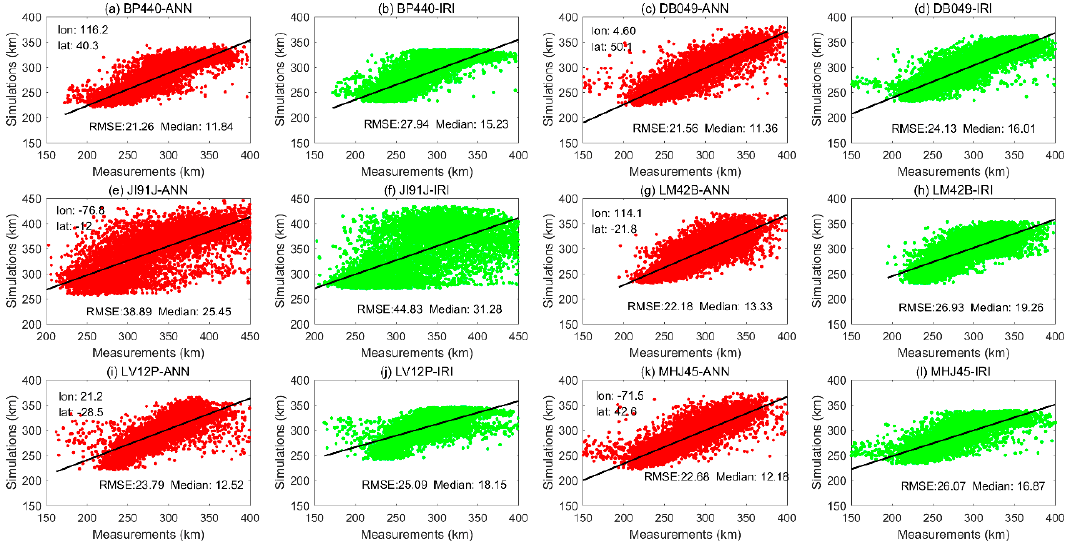
Figure 7. Similar to Figure 6, but for hmF2.